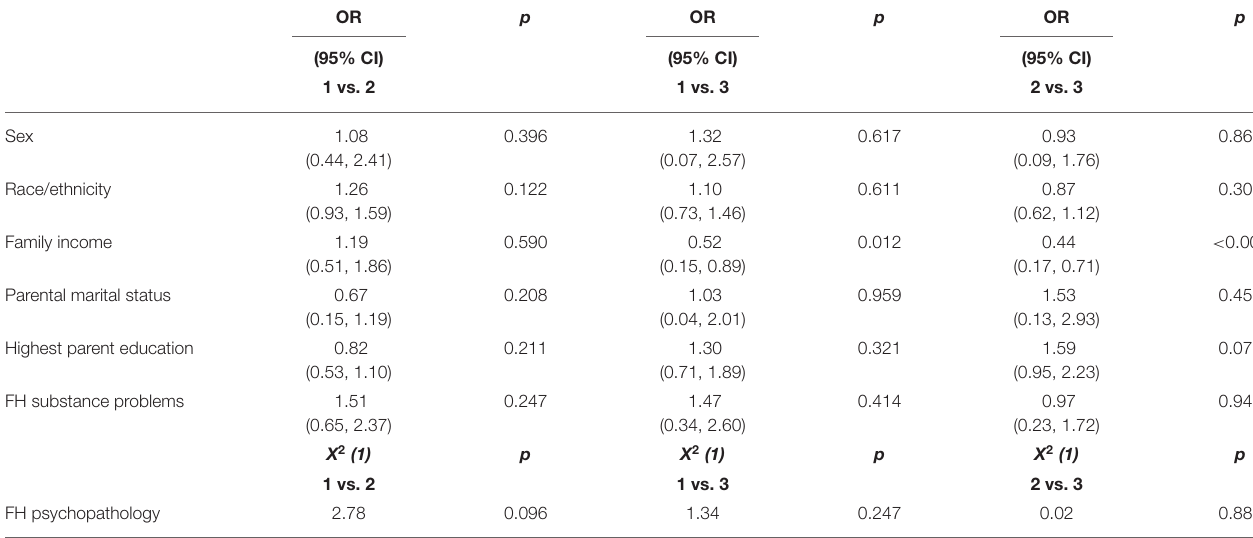
TABLE 5 | Comparisons of latent profiles on demographic variables.